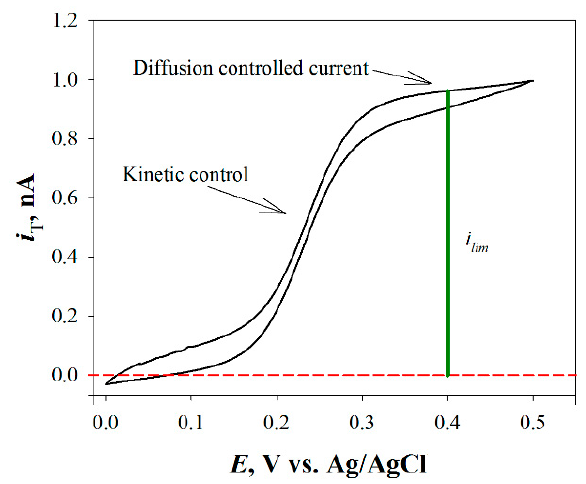
Figure 3. Cyclic voltammetry curve for ferrocene-methanol (i.e., the most employed redox mediator in the literature) on a Pt ME.